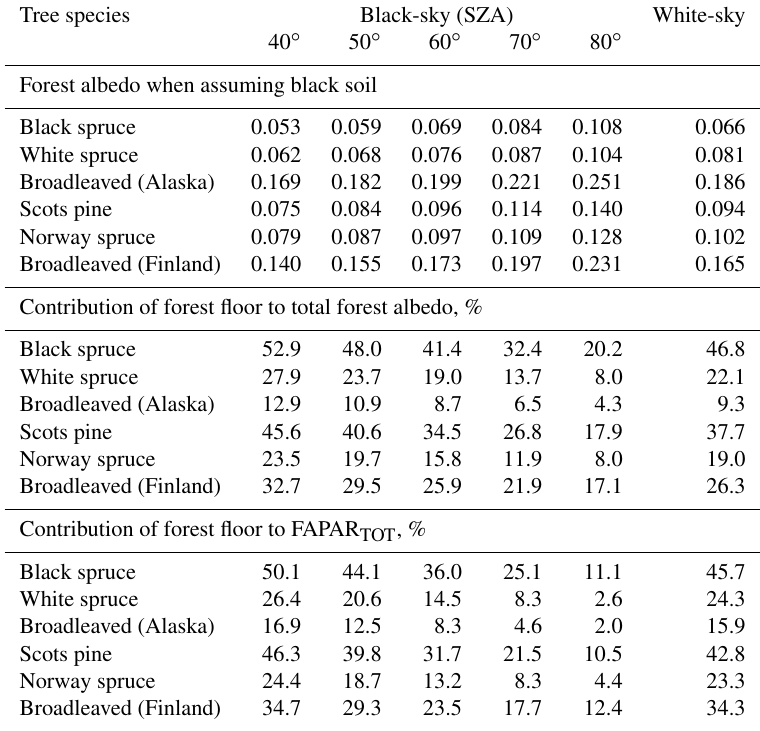
Table 5. Canopy and forest floor contributions to albedo, and forest floor contribution to FAPAR TOT by dominant tree species and SZA. The reported value for given species is the mean of plots in which the basal area proportion of that species exceeded 80%. Note that the values are directly comparable to the species-specific forest albedos and FAPAR values reported in Table 4, i.e., exactly the same plots were used to calculate the average values in both